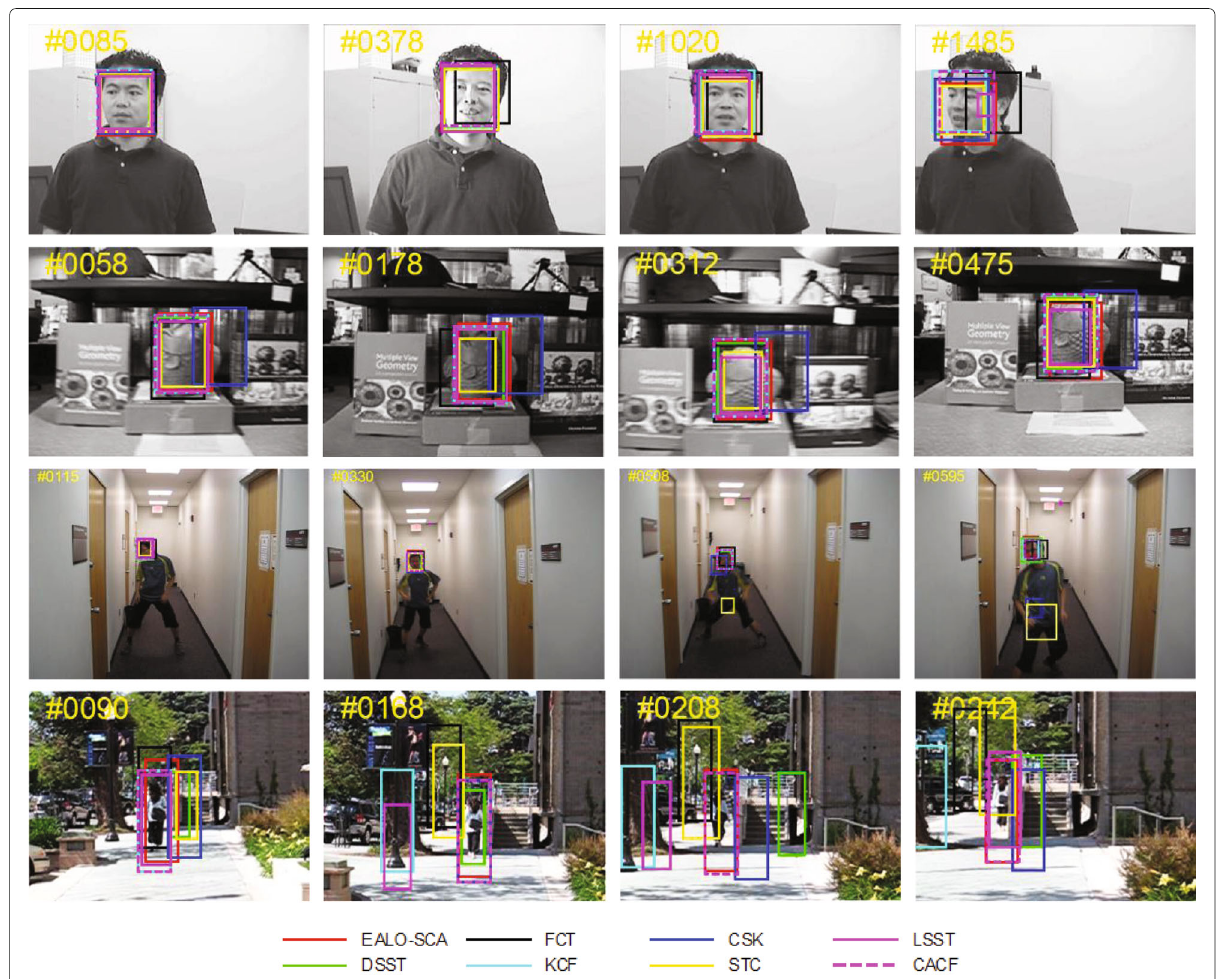
Fig. 10 The tracking results with the slight motion. Sequence 1-4: MHYANG, FISH, BOY, HUMAN7